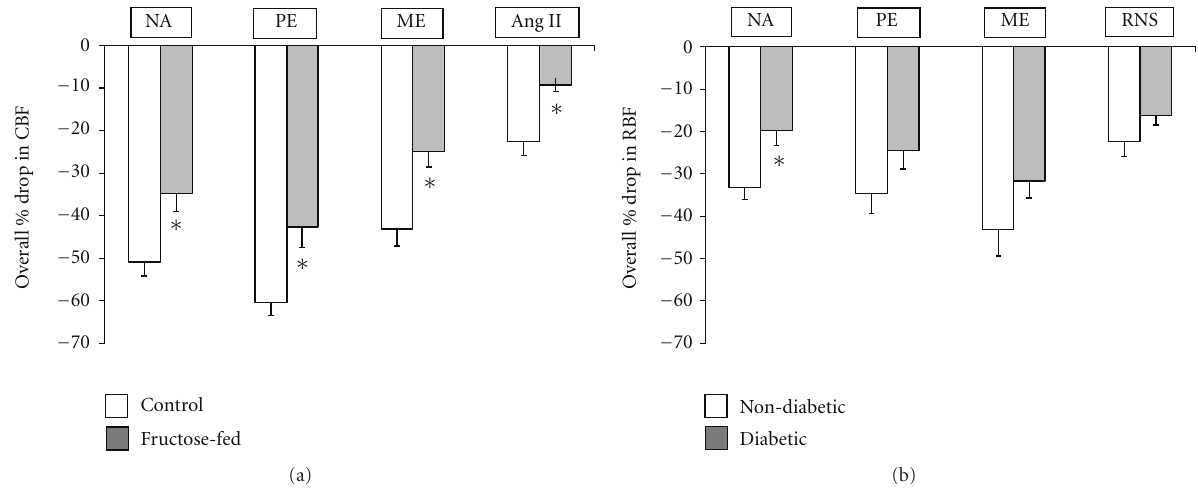
Figure 2: (a) The e ff ect of fructose-feeding on the renal vascular responses to adrenergic agonists and Ang II. The vascular responses, as assessed by the reduction in renal cortical blood flow (CBF) due to adrenergic agonists or Ang II intra-arterial administration (see methods), were significantly lower in fructose-fed (the gray square) compared to control (the white square) animals. (b) The e ff ect of streptozotocin- induced diabetes on the renal vascular responses to adrenergic agonists and renal nerve stimulation. The vascular response to adrenergic stimuli as assessed by reduction in total renal blood flow (RBF) due to renal vasoconstriction was slightly lower although significant only for noradrenaline in diabetic (the gray square) compared to nondiabetic (the white square) rats. Figures are reproduced from Abdulla et al. [16] and Armenia et al. [144] respectively. Data, mean ± SEM represent the overall mean of responses to a range of doses from each agonist. Statistical analysis was performed by unpaired t -test for comparing between two groups each time, ∗ is P < 0 . 05 of fructose-fed versus control in (a) or diabetic versus nondiabetic in (b), ( n = 6). NA: Noradrenaline; PE: phenylephrine; ME: methoxamine; RNS: renal nerve